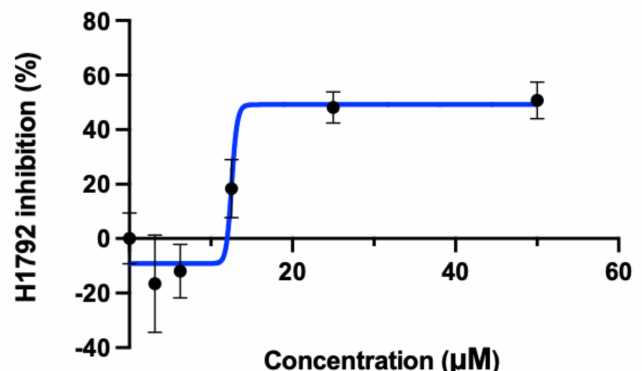
Figure 4. GI50 for osimertinib. The concentration (horizontal axis) of osimertinb is plotted against the H1792 cellular inhibition percentage (vertical axis). The concentration required for 50% cellular inhi- bition (GI50) using osimertinib was calculated to be 12.54 µ M using Graphpad prism 9.0. Although osimertinib was designed to target EGFR-mutant cell lines, here we show that it is also capable of inhibiting KRAS G12C cells as inferred from the predictions made by the CANDO platform. Created with